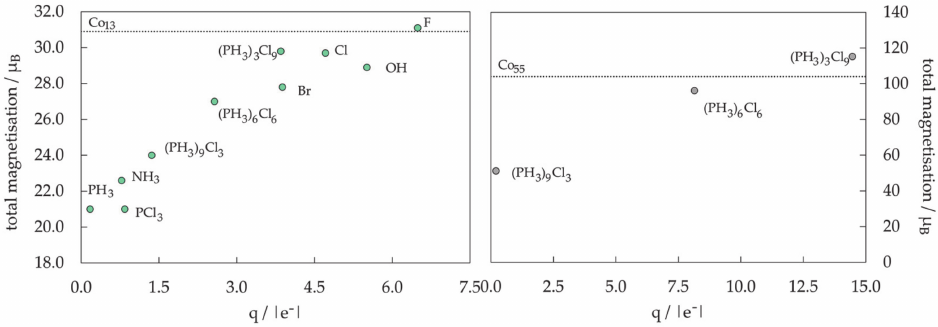
Figure 16. Total magnetic moment as a function of Bader charge for varying ligand shell composition on 13-atom ( left ) and 55-atom ( right ) icosahedral Co mNPs. Dotted lines indicate values of the bare mNPs. Data are taken from Hartmann (2016)